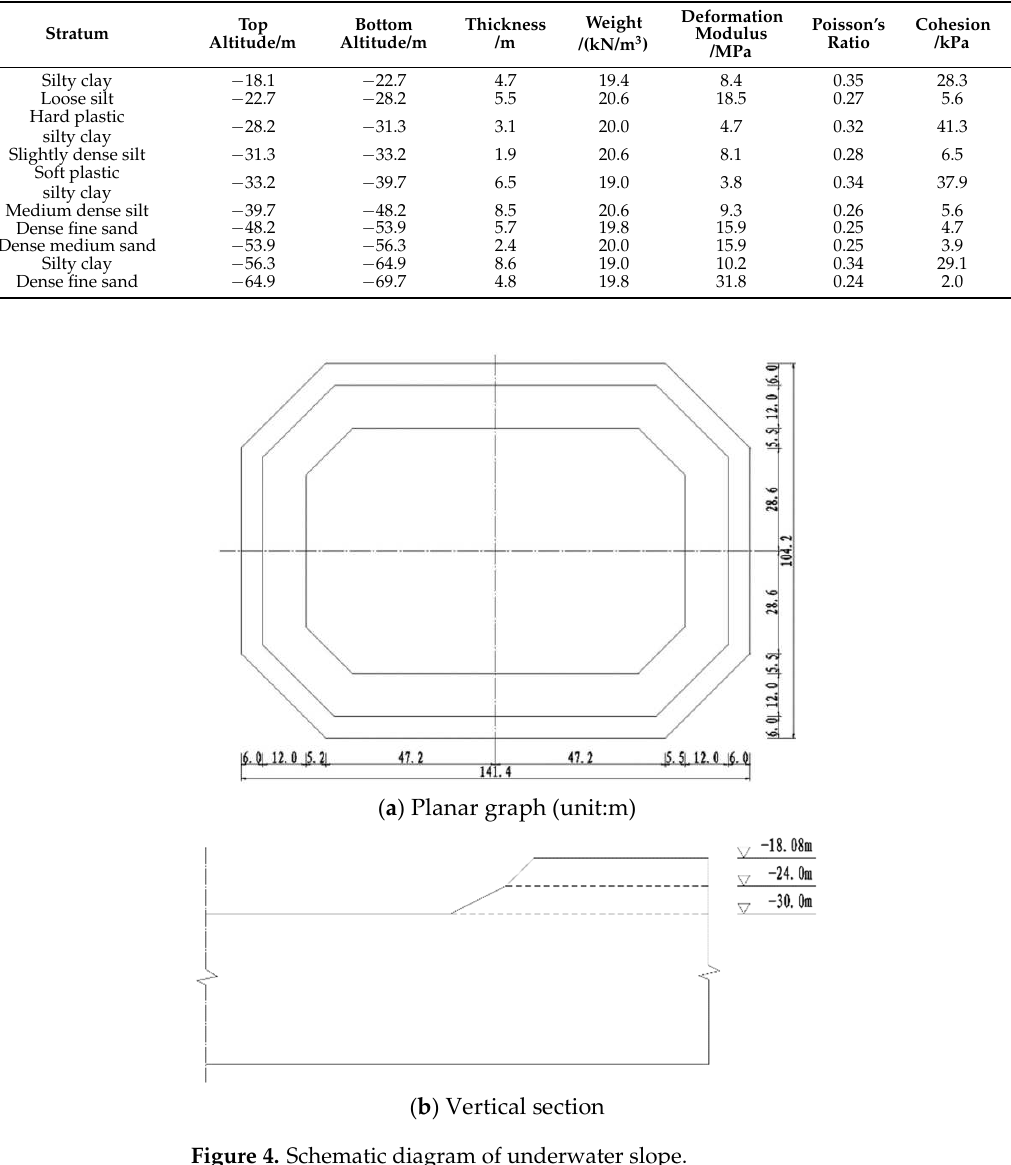
Figure 4. Schematic diagram of underwater